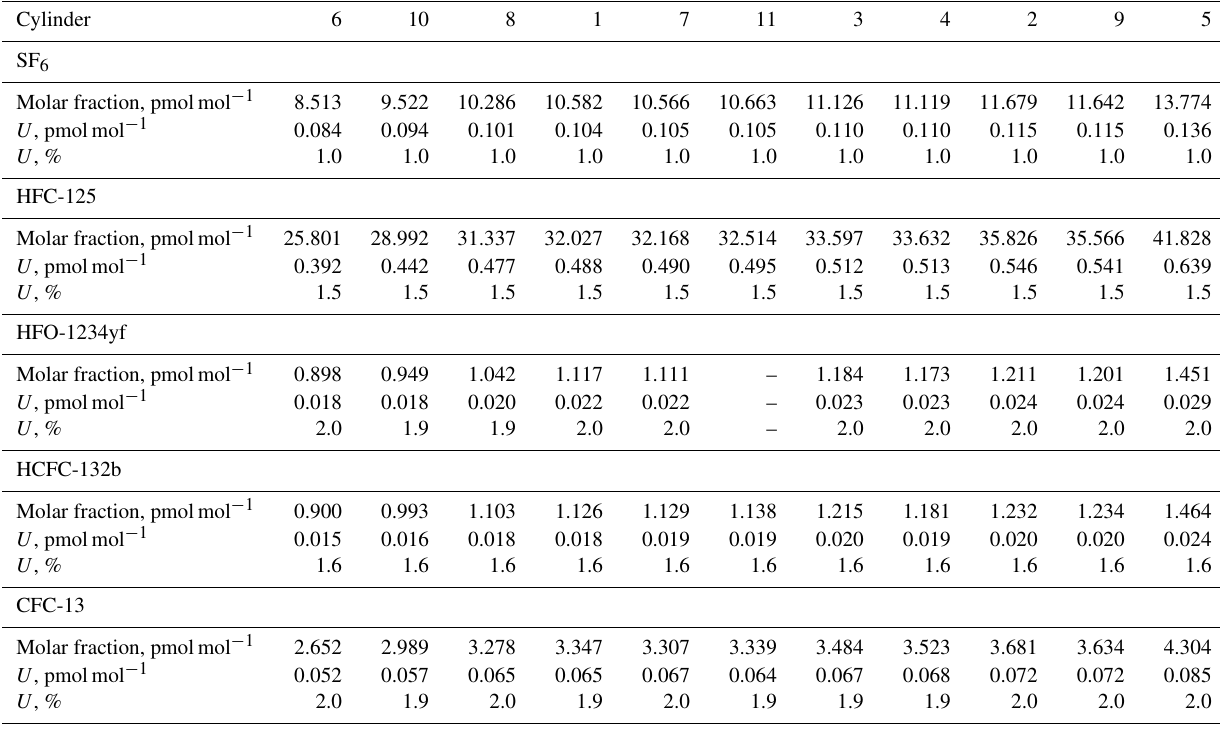
Table 5. METAS-2017 suite of reference gas mixtures: final molar fraction values x meas , corr ,i,j expressed in dry synthetic air and associated uncertainties at a 95% confidence